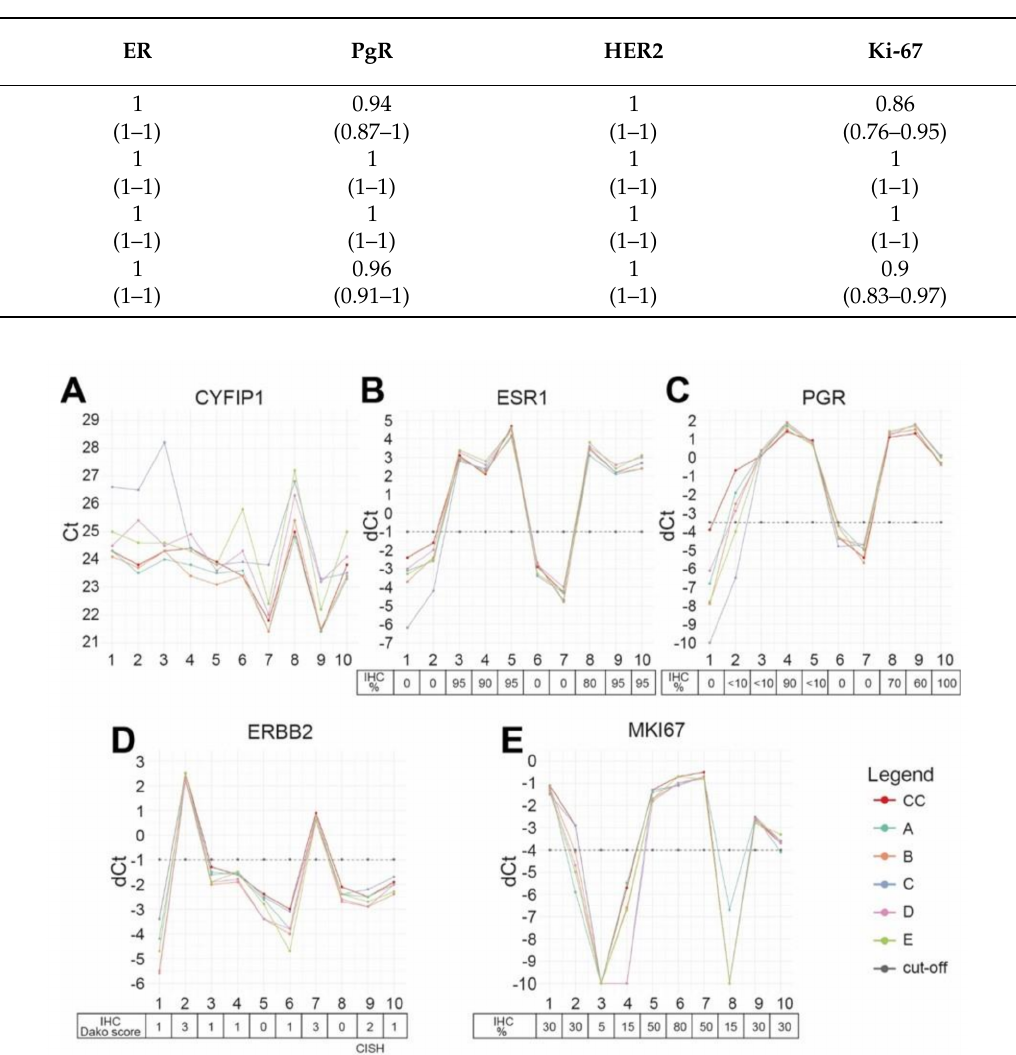
Table 2. Comparison of IHC/ISH status with the STRAT4 binary results. The table shows the average sensitivity, specificity, precision (PPV), and accuracy across all five participating sites (in parenthesis the 95% confidence interval). PPV: positive predictive value.